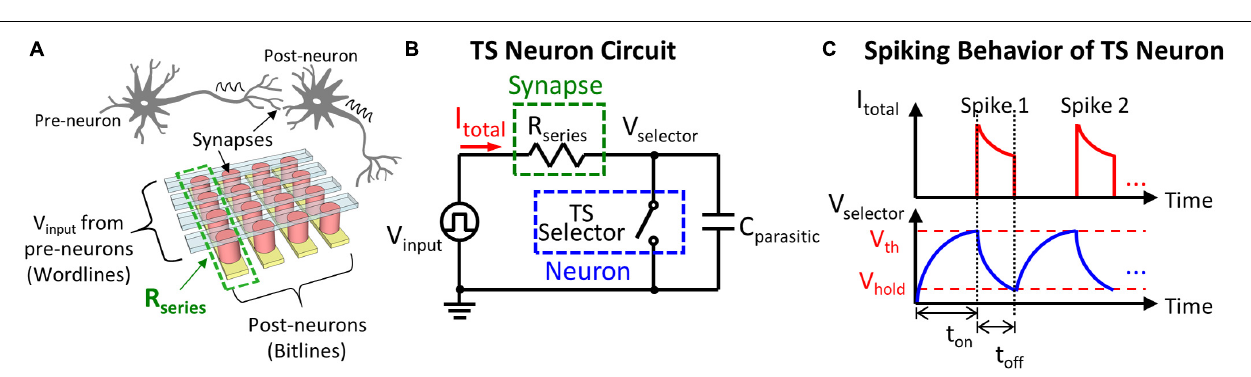
FIGURE 1 | Silver- (Ag-) based threshold switching (TS) selector studied in this study. (A) The schematic structure showing the cross-section view of the Ag/hafnium oxide (HfO x )/Pt device. (B) The top-view scanning electron microscope (SEM) image of Ag nanoparticles (NPs) with an average diameter of 30 nm formed by 500 ◦ C rapid thermal annealing (RTA) for 5 min. The inset shows the size distribution plot of the Ag NPs. (C) DC current–voltage (I–V) characteristics of the device with a current compliance of 0.1 mA, showing the success of TS for 500 DC cycles.